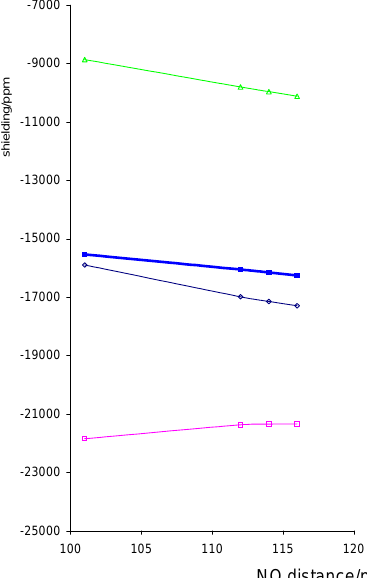
Figure 3. Variation of calculated Co shielding with NO distance for a model porphin complex with r(CoN) = 1.74Å ■ isotropic shielding, □ σ